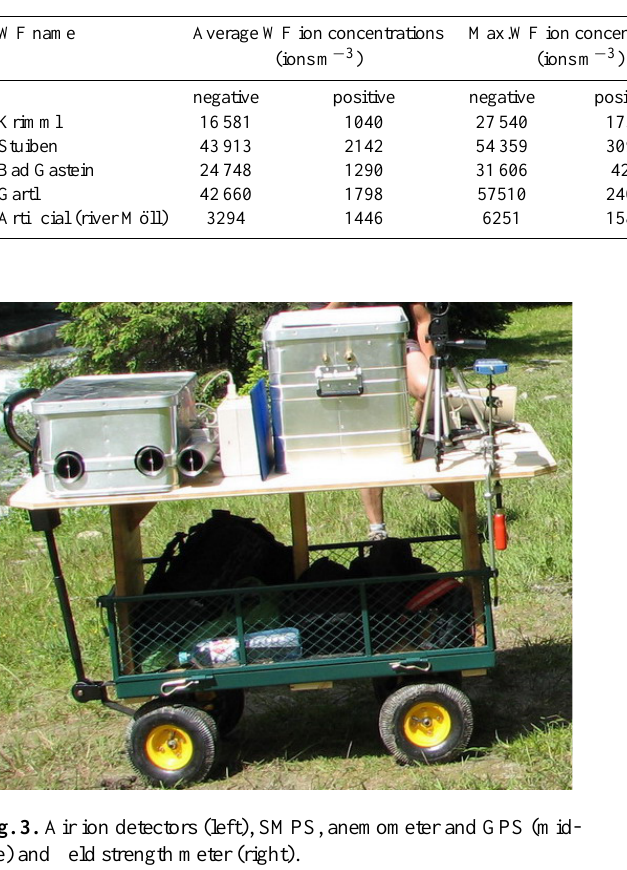
Table 2. Overview of the ion ( ≤ 2nm) concentrations measured at closest range of the WFs and at control places (CP) during July 2008.